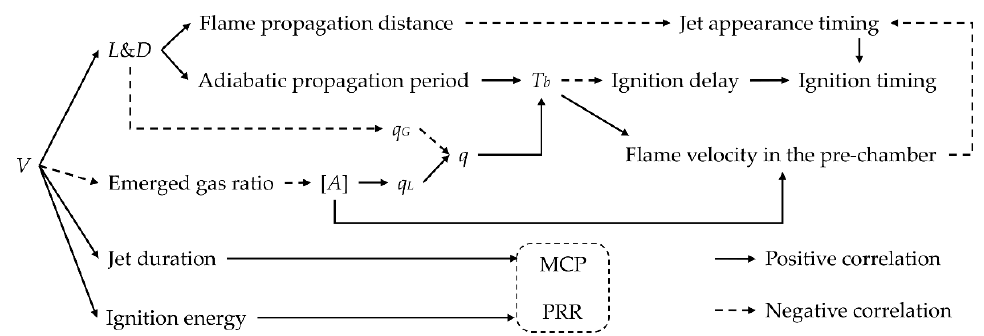
Figure 13. The effects of pre-chamber volume on the process variables, the jet ignition characteristics, and the combustion characteristics.